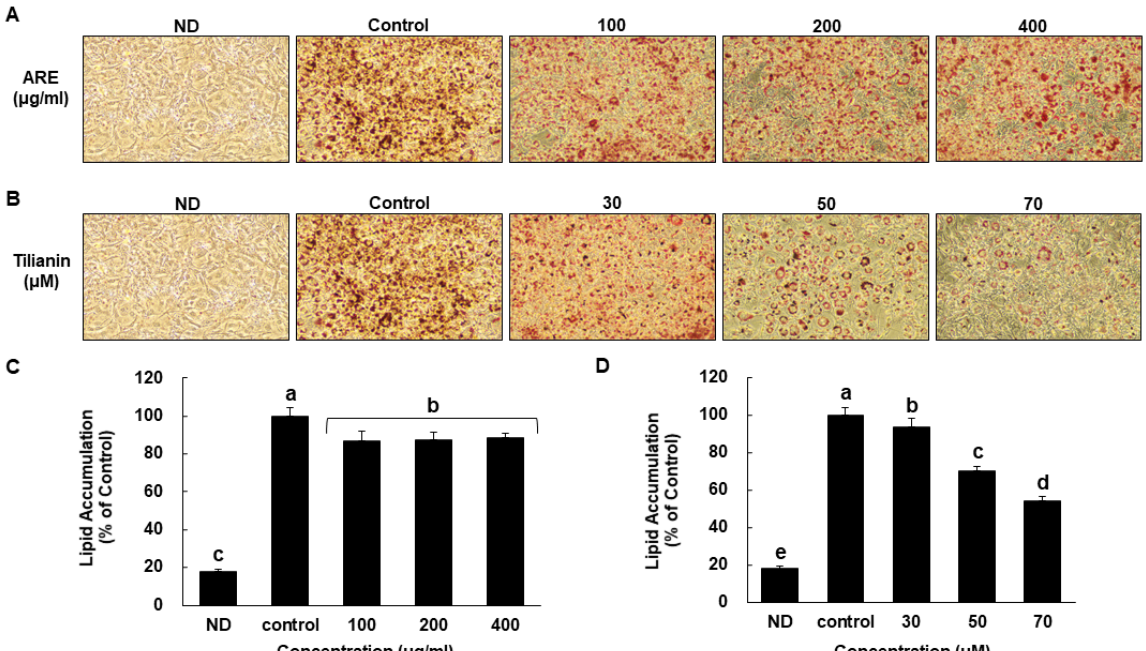
Figure 3. Antiadipogenic effect of ARE and tilianin. 3T3-L1 cells were seeded in 12 well and oil-red-O staining was assessed after treated with differentiation media. With DMSO, oil-red-o was dissolved and the absorption was estimated using spectrophotometer (OD 675 ). Effect of ( A ). ARE and ( B ). tilianin on adipogenic differentiation. Lipid accumulation (% control) quantification in the ( C ). ARE-, ( D ). tilianin-treated groups. ND, nondifferentiated; Control, untreated. Data are means of n = 6. Different letters (a–e) in each graph indicate significantly different values in samples ( p < 0.05, ANOVA Duncan’s test).